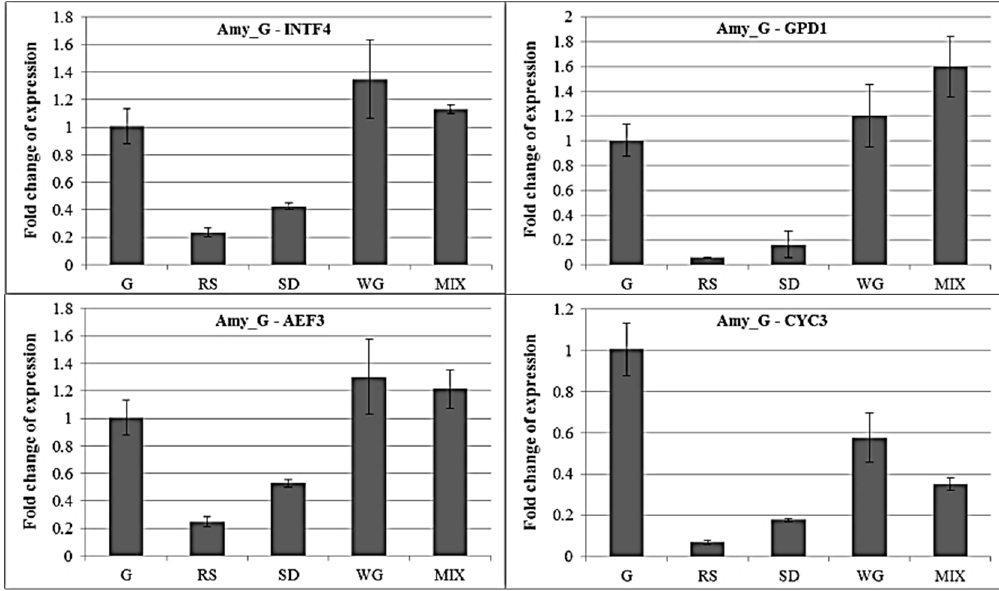
Figure 4. Effects of different normalizing genes on measured relative mRNA abundance.